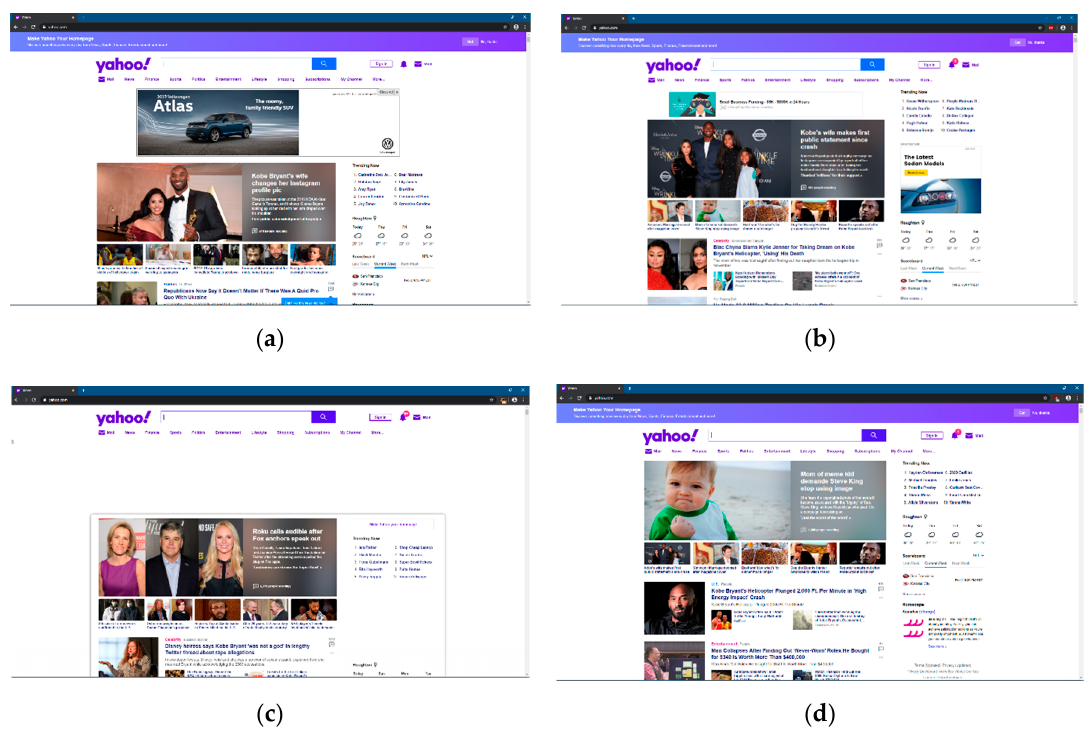
Figure 2. The impact of open source ad blockers on the Yahoo.com website: ( a ) no ad block, ( b ) Figure2. TheimpactofopensourceadblockersontheYahoo.comwebsite: ( a )noadblock, ( b )AdBlock + , AdBlock+, ( c ) Privacy Badger, and ( d ) uBlock Origin. ( c ) Privacy Badger, and ( d ) uBlock Table 2. Average page load times (in seconds) for no ad block, AdBlock+, Privacy Badger, and uBlock Origin as well as the percent of saved load time for each open source ad blocker.